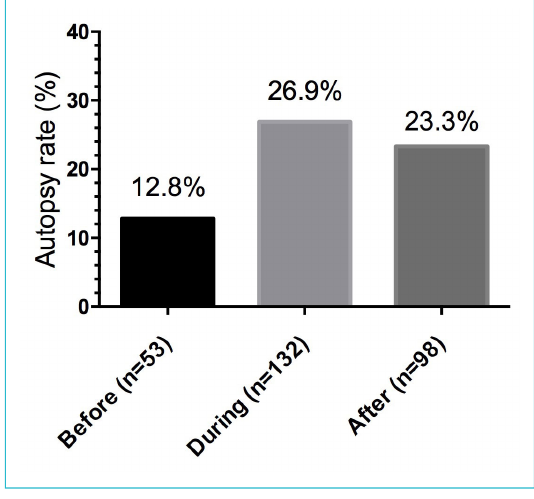
Figure 1: Autopsy rates in 12-month intervals before, during and after the intervention.